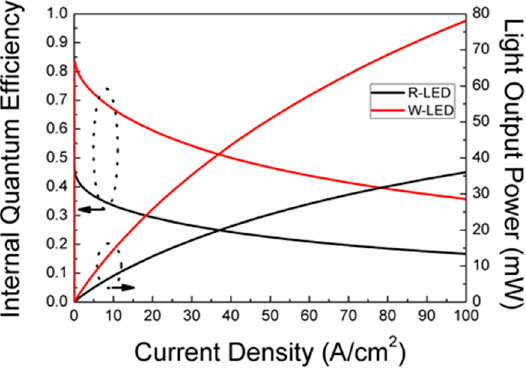
Figure 5. Internal quantum efficiency and light output power of R-LED and W-LED.